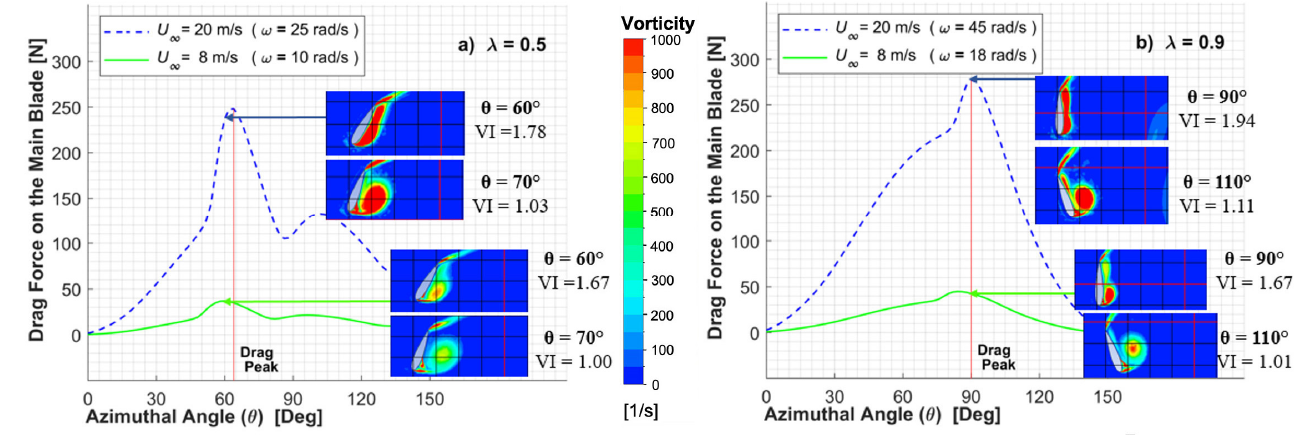
Figure 20. Drag Force and VI for Blade 1 with Azimuthal Position for 𝑈 (cid:2998) = 8 m/s and 𝑈 (cid:2998) = 20 m/s at: (a) 𝜆 = 0.5 and (b) 𝜆 = 0.9, Using the 2D Model of the Present Study.